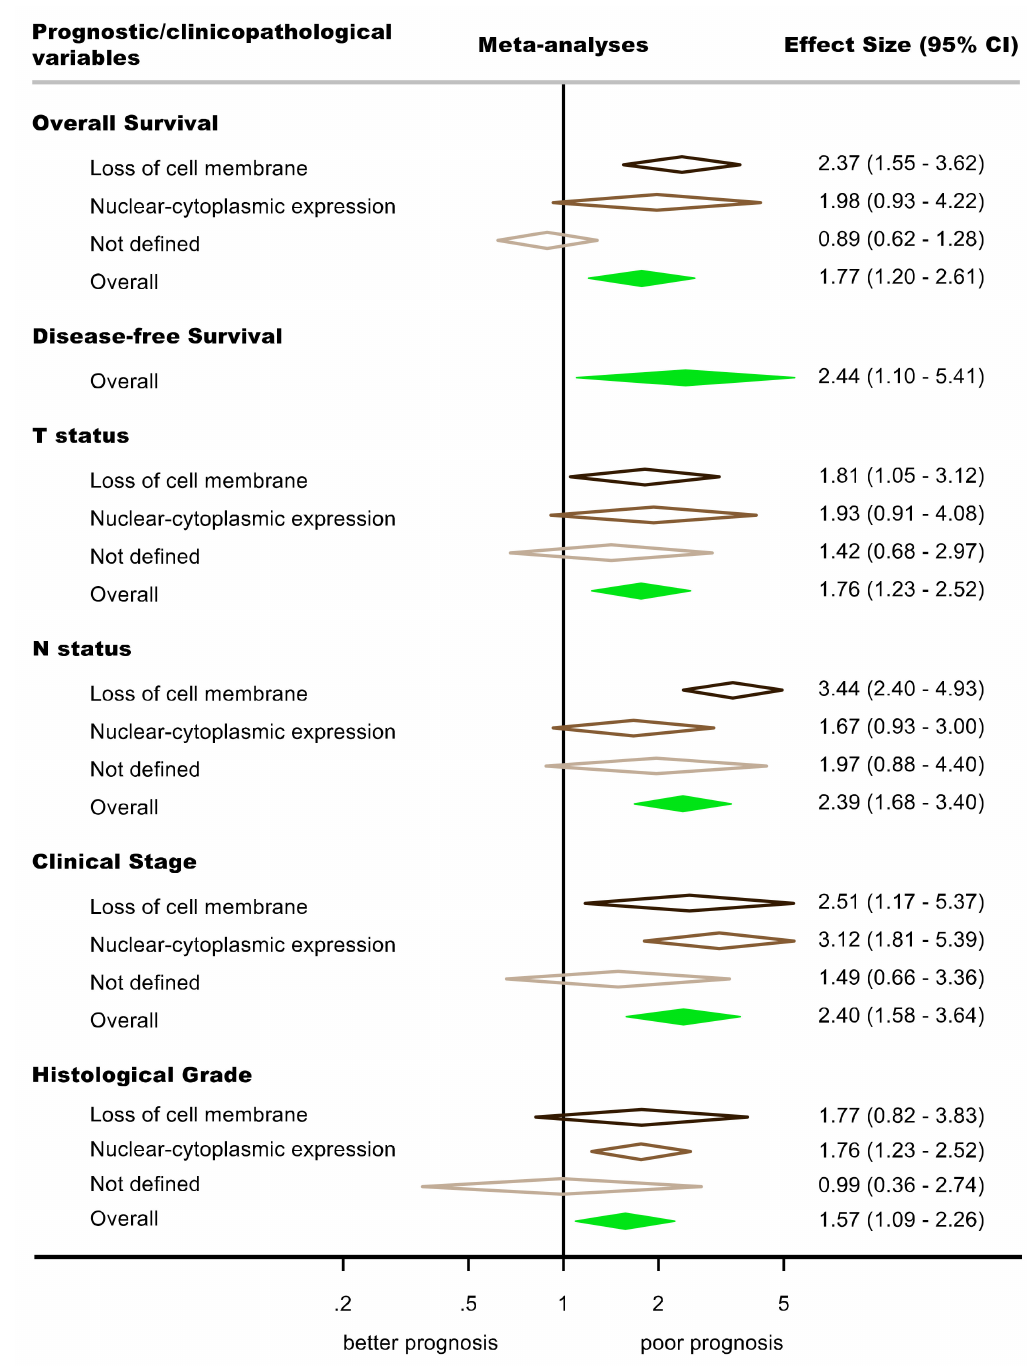
Figure 4. Summary Forest Plot (aka forest top plot) graphically representing the effect sizes (mea- sured as ratio metrics, i.e., hazard ratios for prognostic survival variables, and odds ratios for clinico- pathological parameters) of the aberrant expression of β -catenin in oral squamous cell carcinoma. Each row displays the different meta-analytical results ( n = 21), performed in this study, stratified by subcellular location (dark brown, loss of cell membrane; medium brown, nuclear-cytoplasmic expression; light brown, not defined in primary level studies; green, overall pooled estimates). Random-effects model meta-analyses, inverse-variance weighting based on the DerSimonian and Laird method. An effect size >1 suggests that the aberrant expression of β -catenin is associated with a poor prognosis. Diamonds graphically represent pooled effect sizes with their corresponding 95% confidence intervals